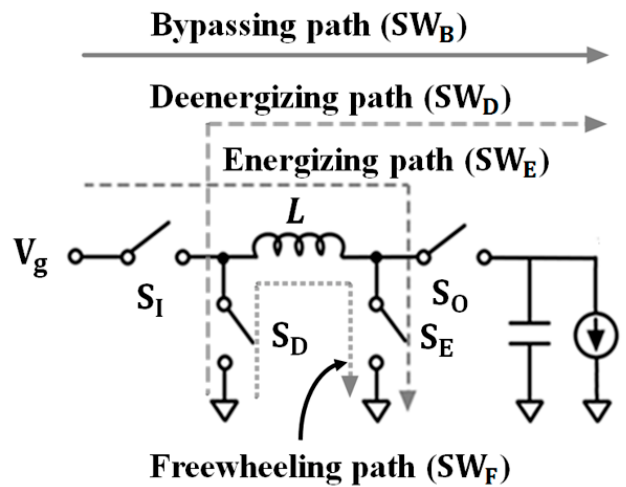
Figure 2. Power stage of a single inductor buck-boost DC–DC converter and switching control modes of inductor current paths.